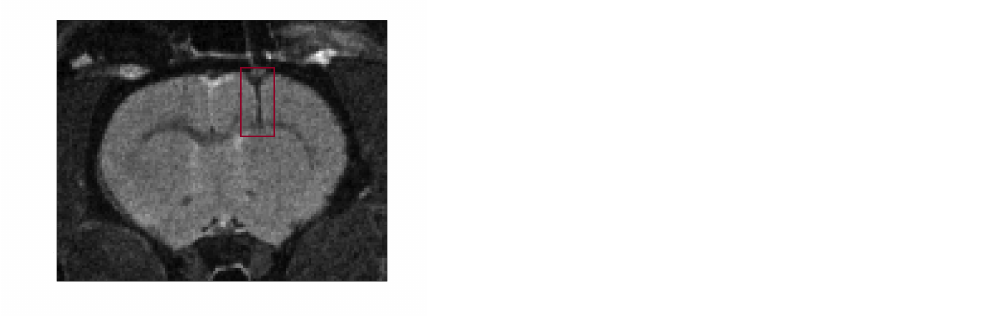
Figure 2. Visualization of the implantable microcoil and the PRESS voxel in anatomical T 2 -weighted MR image of the healthy rat brain.